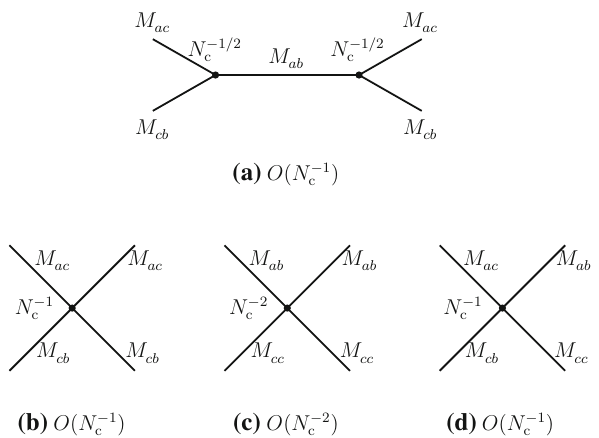
Fig. 11 Significant tree-level vertex diagrams with meson propagators in the direct channel I ( a , b ), the direct channel II ( c ) and the recombi- nation channel ( d